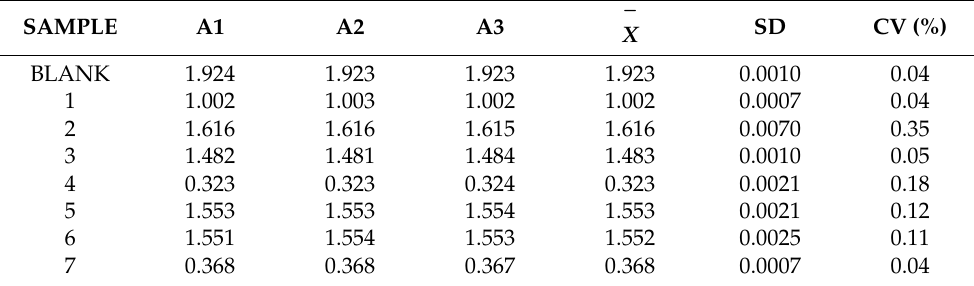
Table 2. Absorbances obtained for lypophilic extracts of cream samples (DPPH method).